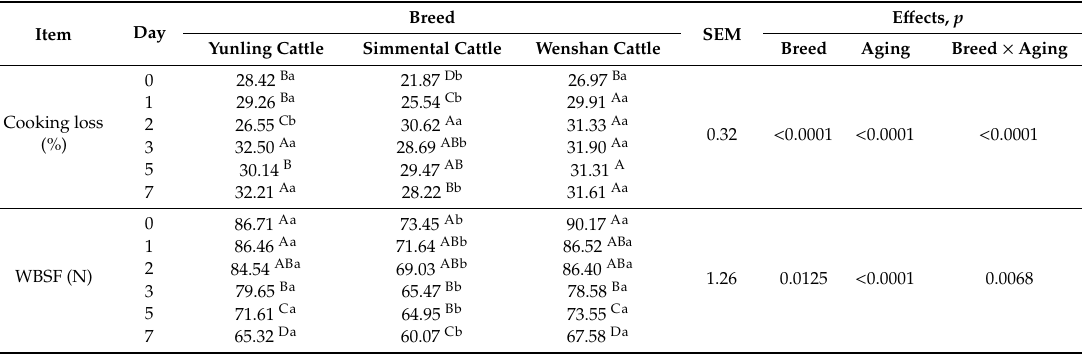
Table 4. The cooking loss and Warner-Bratzler shear force (WBSF) a ff ected by breed and aging.